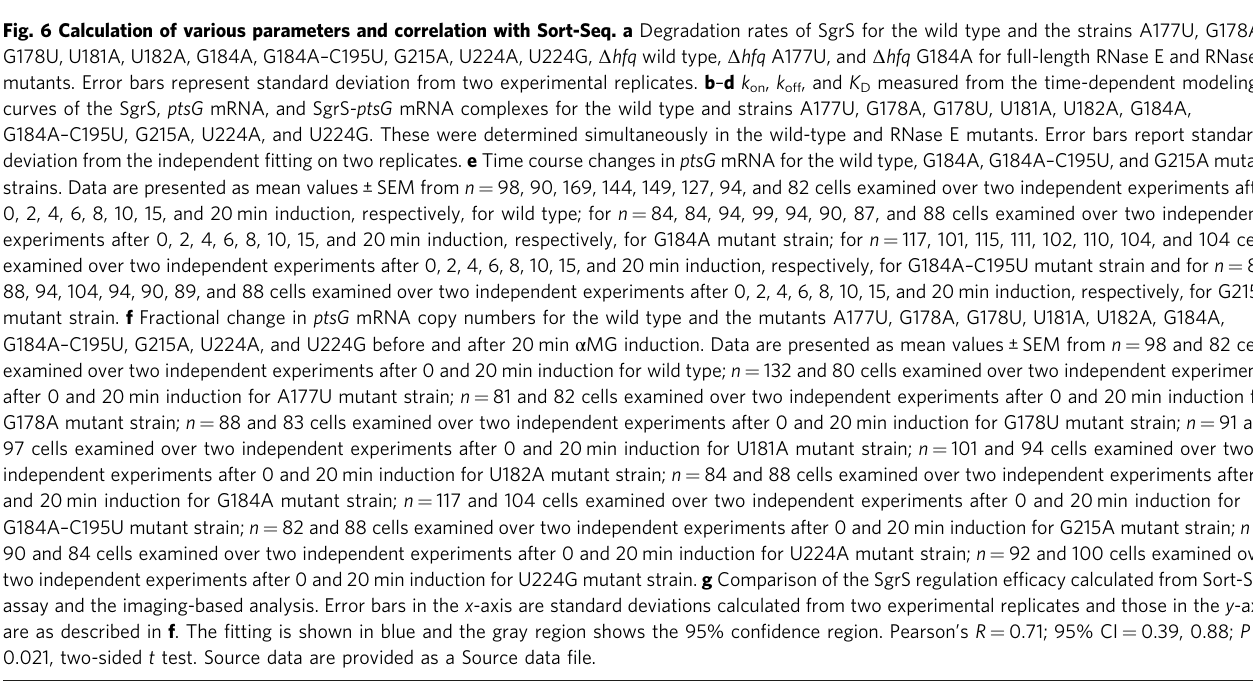
Fig. 6 Calculation of various parameters and correlation with Sort-Seq. a Degradation rates of SgrS for the wild type and the strains A177U, G178A, G178U, U181A, U182A, G184A, G184A – C195U, G215A, U224A, U224G, Δ hfq wild type, Δ hfq A177U, and Δ hfq G184A for full-length RNase E and RNase E mutants. Error bars represent standard deviation from two experimental replicates. b – d k on , k off , and K D measured from the time-dependent modeling curves of the SgrS, ptsG mRNA, and SgrS- ptsG mRNA complexes for the wild type and strains A177U, G178A, G178U, U181A, U182A, G184A, G184A – C195U, G215A, U224A, and U224G. These were determined simultaneously in the wild-type and RNase E mutants. Error bars report standard deviation from the independent fi tting on two replicates. e Time course changes in ptsG mRNA for the wild type, G184A, G184A – C195U, and G215A mutant strains. Data are presented as mean values ± SEM from n = 98, 90, 169, 144, 149, 127, 94, and 82 cells examined over two independent experiments after 0, 2, 4, 6, 8, 10, 15, and 20 min induction, respectively, for wild type; for n = 84, 84, 94, 99, 94, 90, 87, and 88 cells examined over two independent experiments after 0, 2, 4, 6, 8, 10, 15, and 20 min induction, respectively, for G184A mutant strain; for n = 117, 101, 115, 111, 102, 110, 104, and 104 cells examined over two independent experiments after 0, 2, 4, 6, 8, 10, 15, and 20 min induction, respectively, for G184A – C195U mutant strain and for n = 82, 88, 94, 104, 94, 90, 89, and 88 cells examined over two independent experiments after 0, 2, 4, 6, 8, 10, 15, and 20 min induction, respectively, for G215A mutant strain. f Fractional change in ptsG mRNA copy numbers for the wild type and the mutants A177U, G178A, G178U, U181A, U182A, G184A, G184A – C195U, G215A, U224A, and U224G before and after 20 min α MG induction. Data are presented as mean values ± SEM from n = 98 and 82 cells examined over two independent experiments after 0 and 20 min induction for wild type; n = 132 and 80 cells examined over two independent experiments after 0 and 20 min induction for A177U mutant strain; n = 81 and 82 cells examined over two independent experiments after 0 and 20 min induction for G178A mutant strain; n = 88 and 83 cells examined over two independent experiments after 0 and 20 min induction for G178U mutant strain; n = 91 and 97 cells examined over two independent experiments after 0 and 20 min induction for U181A mutant strain; n = 101 and 94 cells examined over two independent experiments after 0 and 20 min induction for U182A mutant strain; n = 84 and 88 cells examined over two independent experiments after 0 and 20 min induction for G184A mutant strain; n = 117 and 104 cells examined over two independent experiments after 0 and 20 min induction for G184A – C195U mutant strain; n = 82 and 88 cells examined over two independent experiments after 0 and 20 min induction for G215A mutant strain; n = 90 and 84 cells examined over two independent experiments after 0 and 20 min induction for U224A mutant strain; n = 92 and 100 cells examined over two independent experiments after 0 and 20 min induction for U224G mutant strain. g Comparison of the SgrS regulation ef fi cacy calculated from Sort-Seq assay and the imaging-based analysis. Error bars in the x -axis are standard deviations calculated from two experimental replicates and those in the y -axis are as described in f . The fi tting is shown in blue and the gray region shows the 95% con fi dence region. Pearson ’ s R = 0.71; 95% CI = 0.39, 0.88; P = 0.021, two-sided t test. Source data are provided as a Source data fi